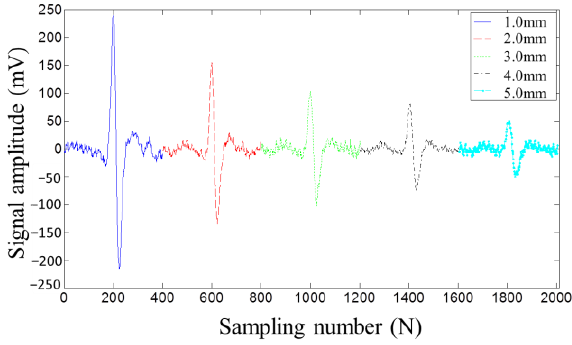
Figure 8. The MFL signals picked up by the induction coil at different lift-off distances.